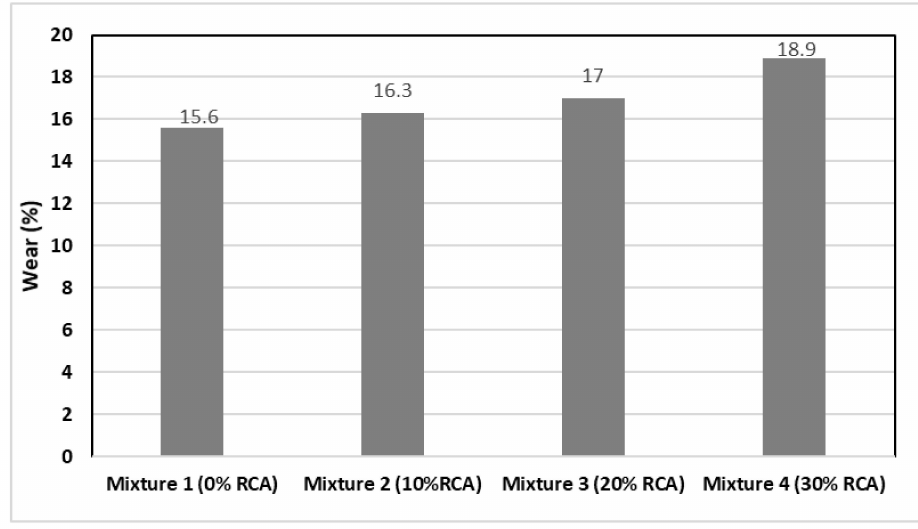
Figure 5. Resistance to degradation by abrasion and impact of the designed mixtures.